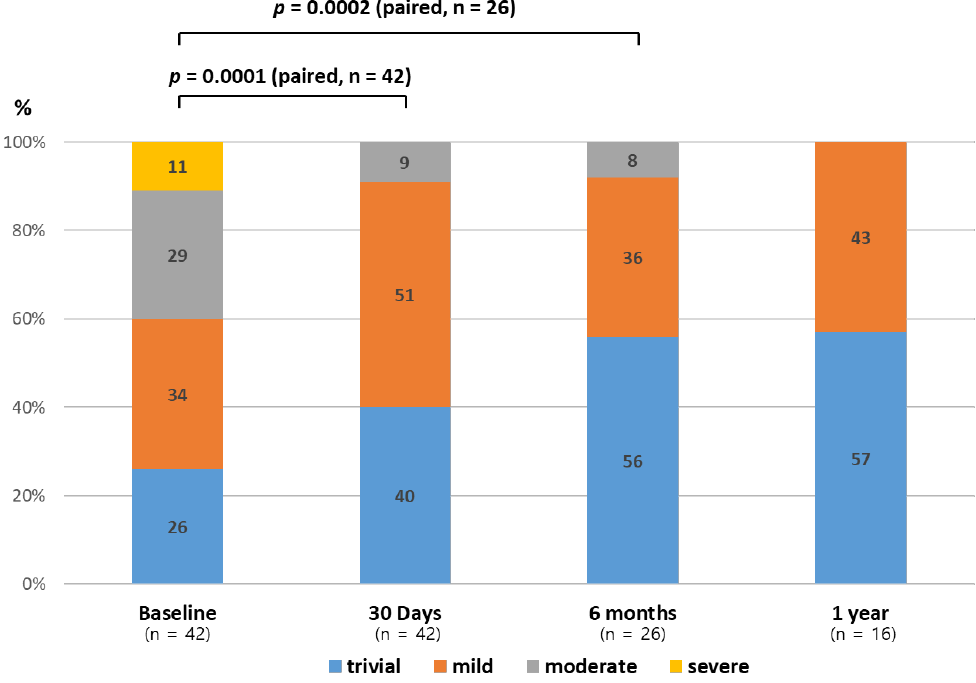
Figure 3. Changes in right ventricular volume before and 1 year after valve implantation. The mean indexed RV (right ventricle) end-diastolic volume index was significantly decreased after valve implantation, as seen on a cardiac MRI (magnetic resonance image).